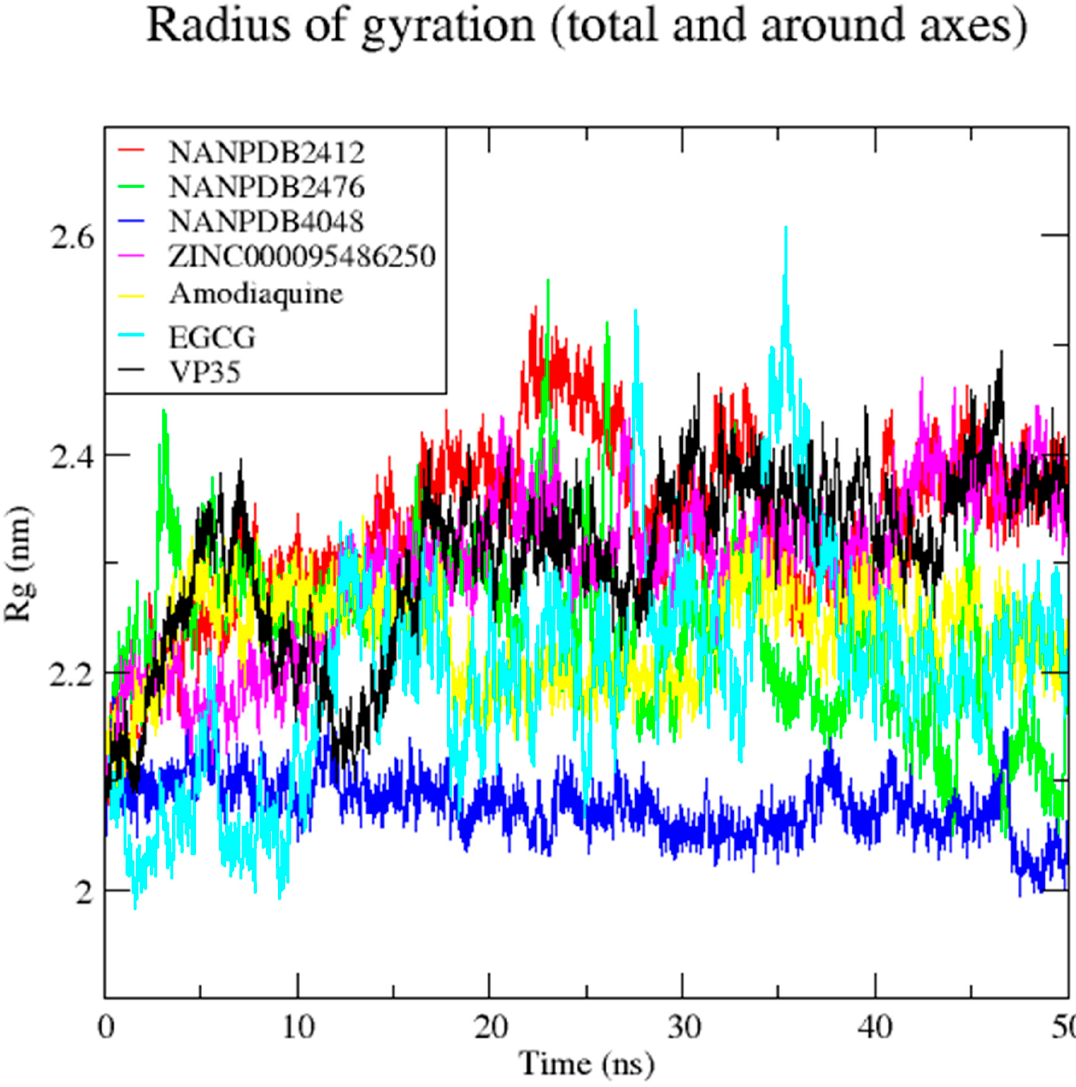
Figure 5. The time evolution of radius of gyration (Rg) for the EBOV VP35-complexes: Amodiaquine, EGCG, NANPDB4048, NANPDB2412, NANPDB2476, ZINC000095486250 and VP35 are indicated in yellow, cyan, blue, red, green, magenta and black,